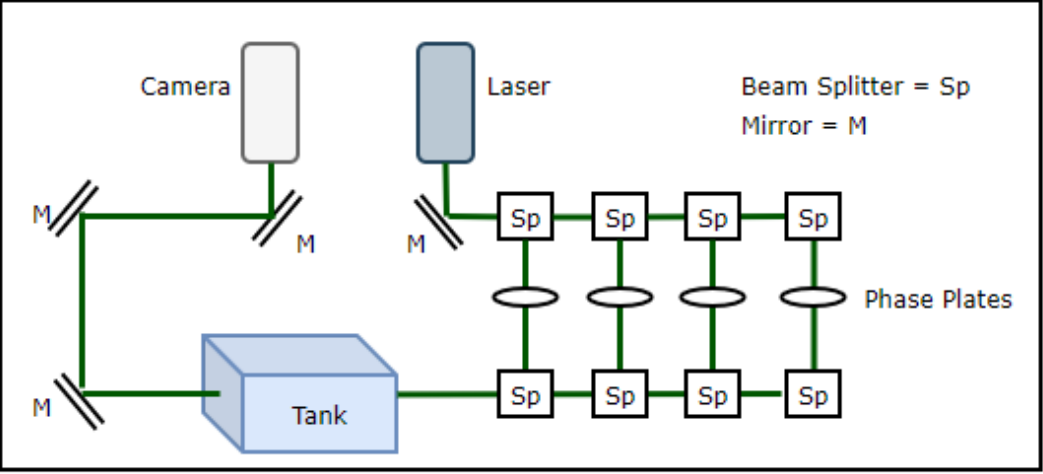
Figure 4. Bench setup for underwater OAM communication